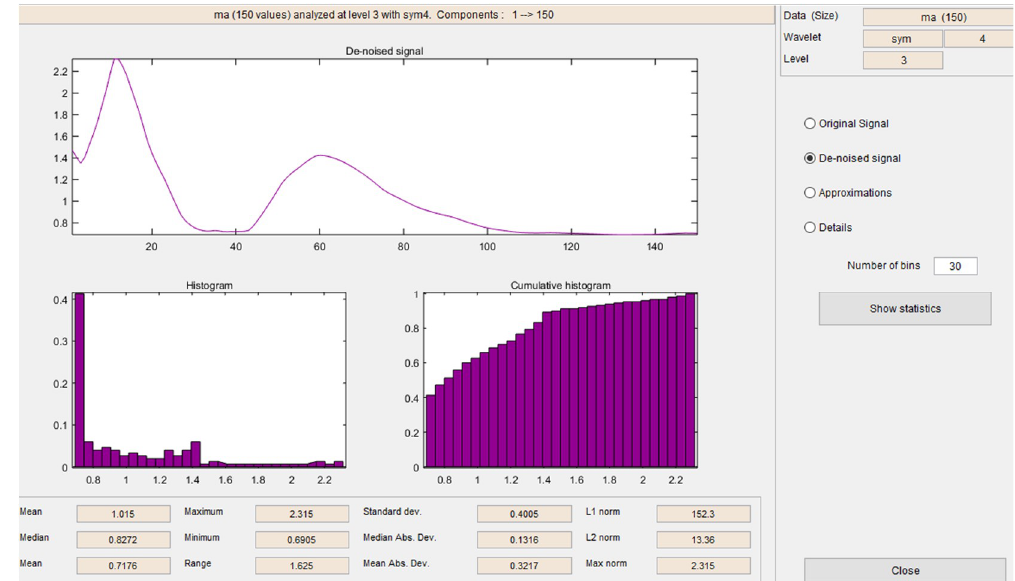
Figure 20. Statistical data of the de-noise signal of the approximation coefficients in level 3 related to the upward movement.